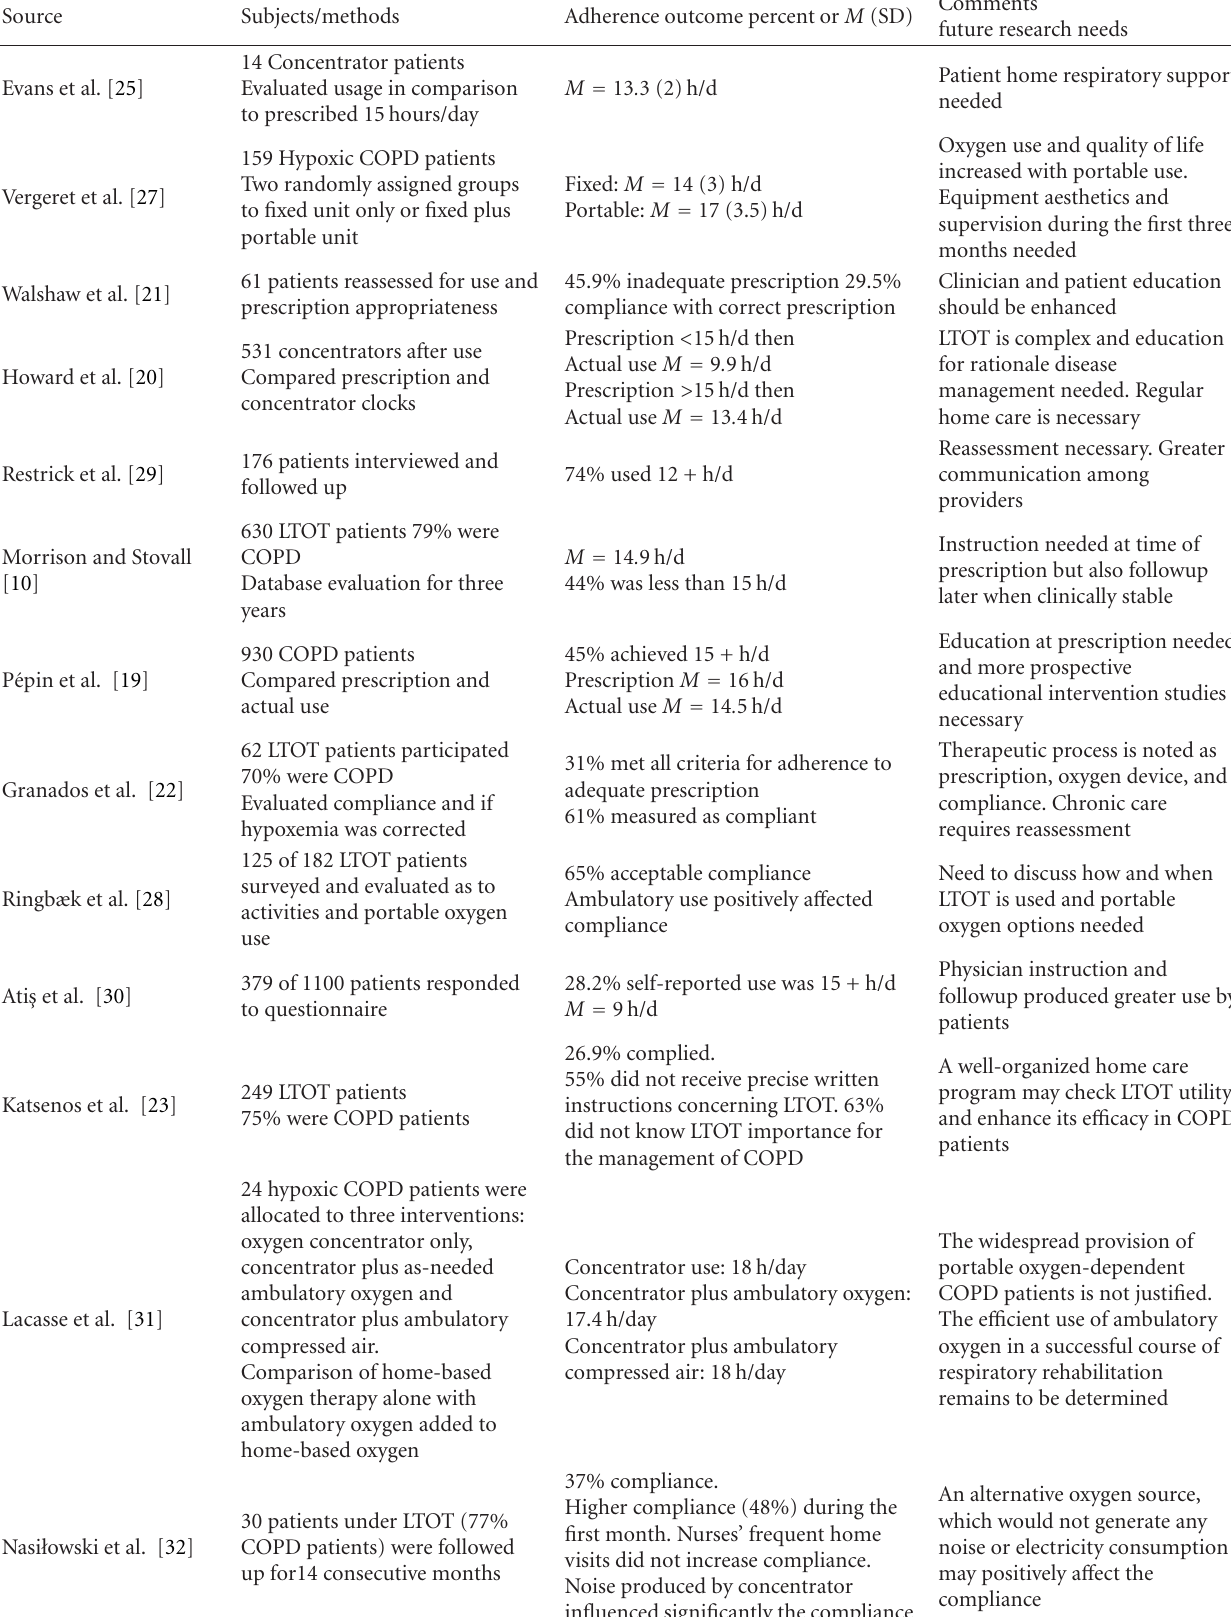
Table 1: Overview of adherence evaluation for